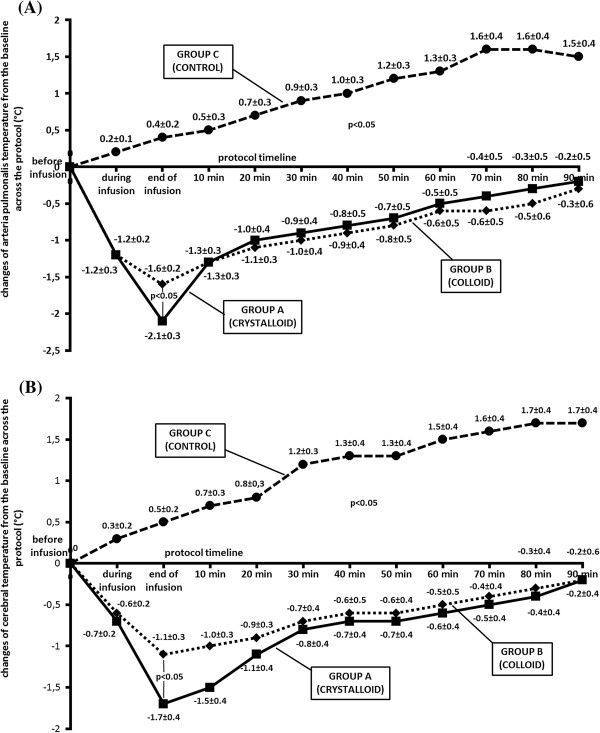
Course of changes in arteria pulmonalis and cerebral body temperature during the protocol in all groups. (A) Arteria pulmonalis body temperature (BT). (B) Cerebral BT. Solid line, group A; dotted line, group B; dashed line, group C.